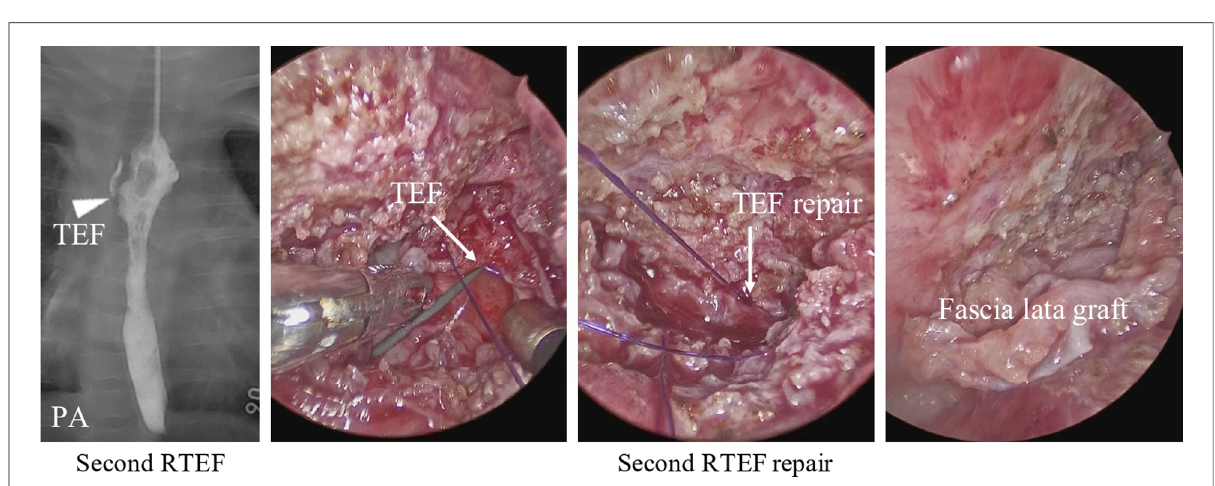
FIGURE 2 A contrast examination of the esophagus 2 months after the primary surgery shows an RTEF at the proximal site of anastomosis (arrowhead). The TEF was closed with sutures and the placement of a pleural patch (arrow) at the fi rst RTEF repair. A contrast examination of the esophagus after the fi rst RTEF surgery shows no apparent recurrent TEF. RTEF, recurrent tracheoesophageal fi stula.